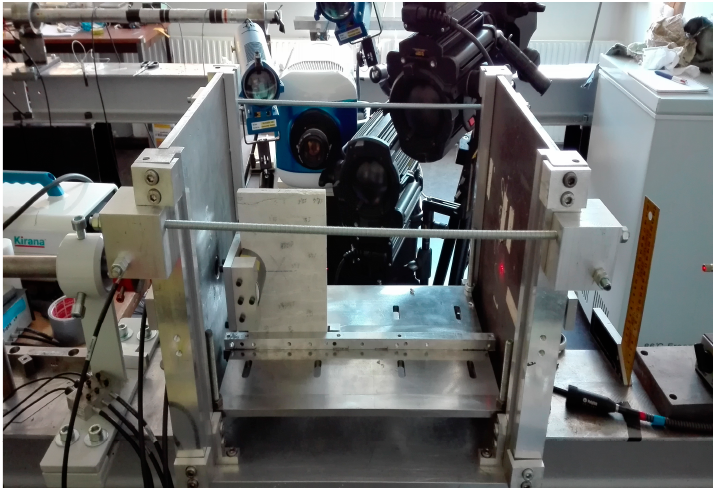
2391 A Kirana ultra-high-speed camera providing 180 pictures with a resolution of 924 × 768 pixels was used in an open configuration with a recording frequency set to 400 kfps. The camera is triggered with a laser interferometer directed to the centre of the target’s rear-edge, with a triggering level set to 2 m/s. Two pictures of the specimen are shown in